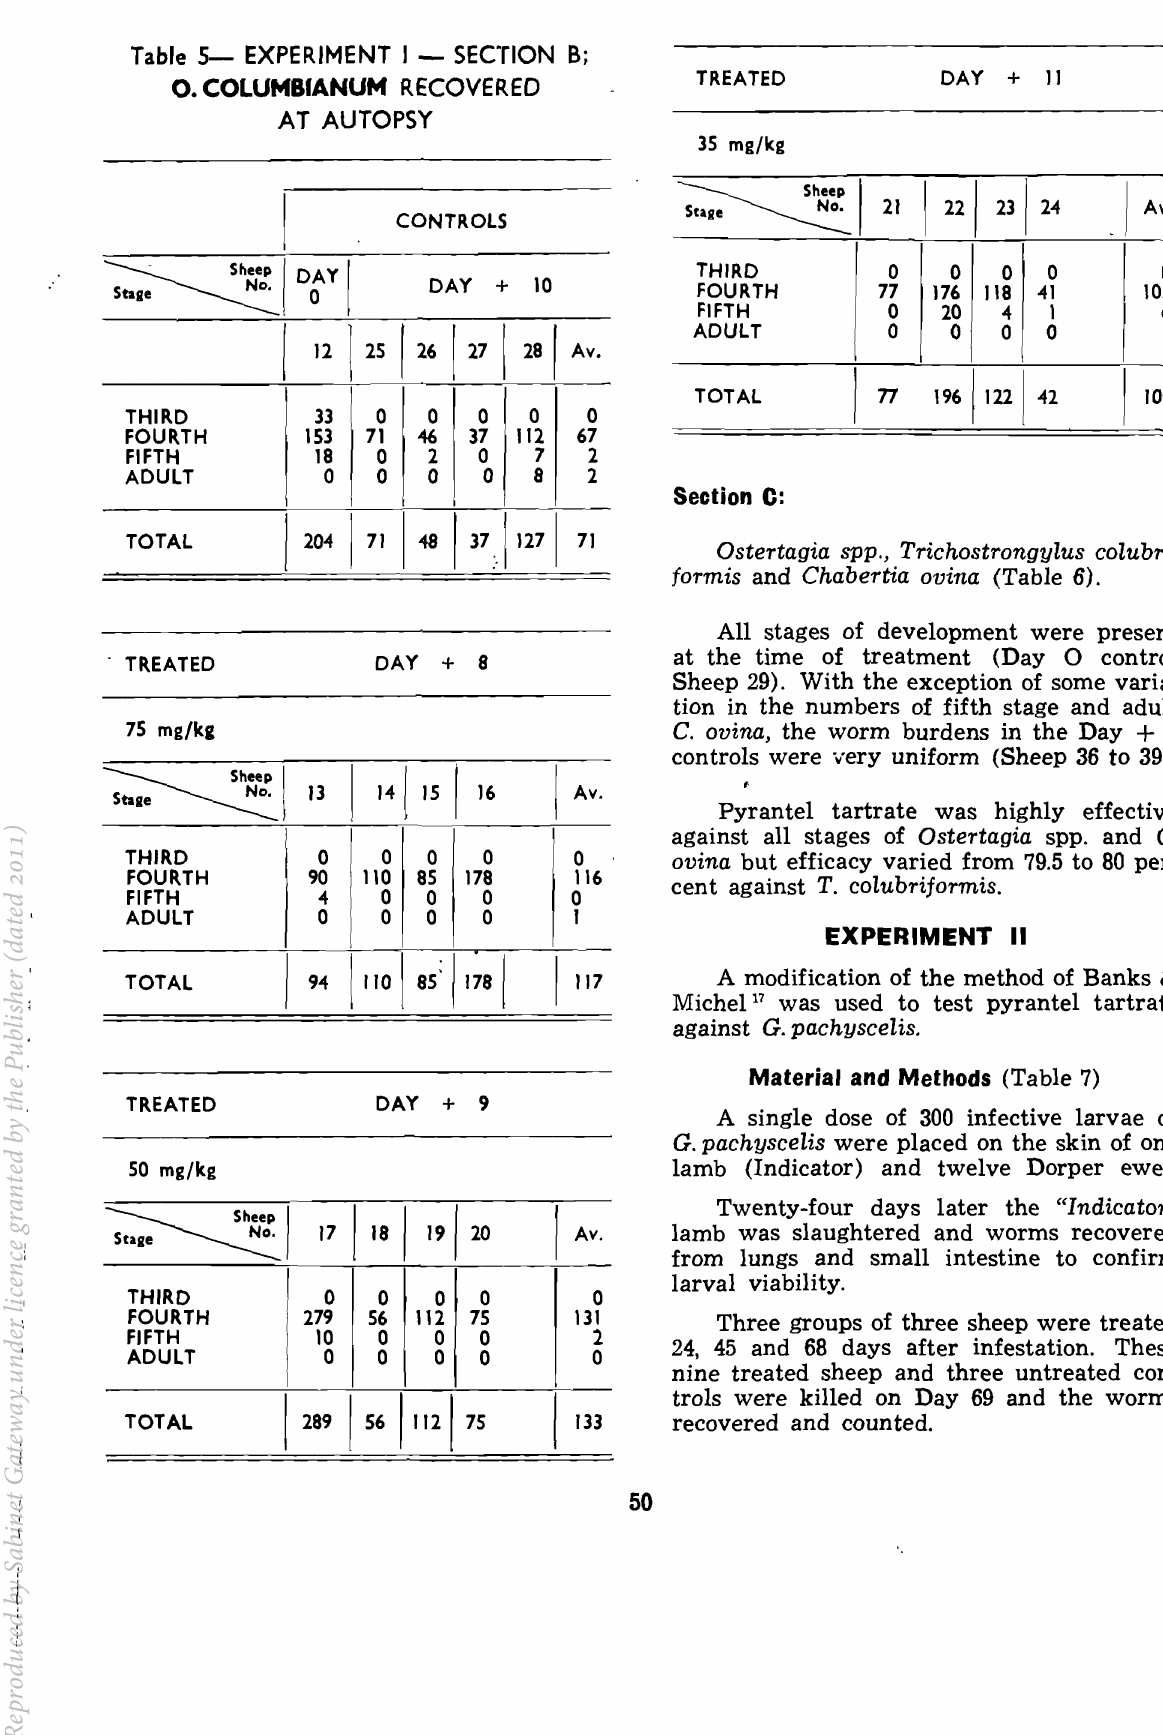
Table 5- EXPERIMENT I - O. COLUMBIANUM